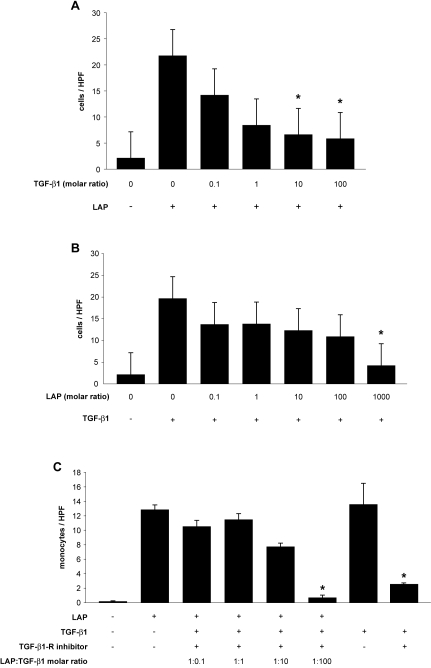
TGF-β1 is able to inhibit LAP-induced monocyte recruitment.(A) 10 pg/ml of rhLAP (dose with maximal response) was used as the
chemoattractant for freshly isolated human peripheral blood monocytes in
chemotaxis chambers and assessed as in previous experiments. Increasing
doses of active rhTGF-β1 were pre-incubated with the
chemoattractant prior to exposure to the monocyte suspensions
(*, p<0.05 vs. LAP alone). (B) To compare this to the
activity of LAP as an inhibitor of active rhTGF-β1 function in
this system, we performed parallel experiments where the conditions were
reversed. Active rhTGF-β1 was used at its maximal effective dose
(100 pg/ml) based on prior experiments (data not shown). (*,
p<0.05 vs. TGF-β1 alone) All bars represent the
mean±SEM. (C) Assessment of LAP-mediated recruitment
independent of TGF-β1 receptor activity in these experiments was
assayed using SB 431542 hydrate, a selective inhibitor of TGF-β
type 1 receptor kinases (TGF-β1-receptor inhibitor). Cell
suspensions were preincubated for 20 minutes with 10 µM SB
431542 (optimal dose blocking TGF-β−induced signaling)
or DMSO. 10 pg/ml of rhLAP (dose with maximal response) was used as the
chemoattractant for freshly isolated human peripheral blood monocytes in
chemotaxis chambers and assessed as in previous experiments. Increasing
doses of active rhTGF-β1 were pre-incubated with the
chemoattractant prior to exposure to the monocyte suspensions
(*, p<0.05 vs. LAP alone) (*, p<0.05 vs.
TGF-β1 alone). All bars represent the mean±SEM for
n = 3 samples.